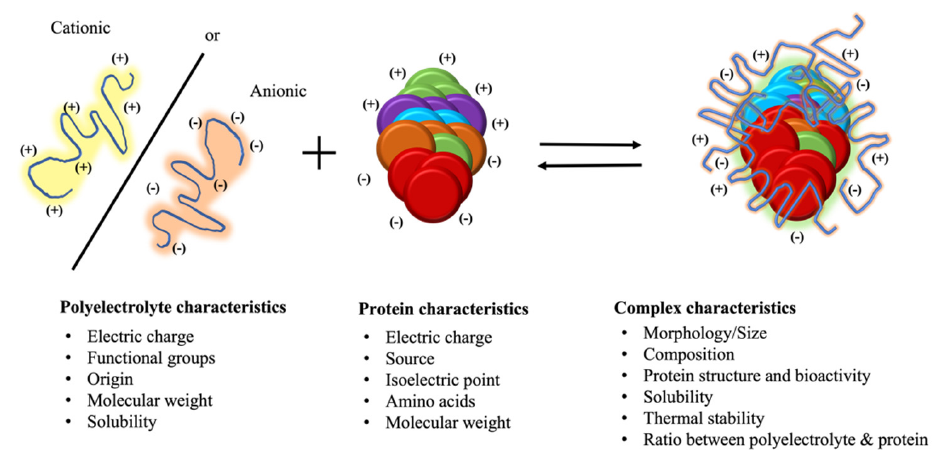
Figure 2. Schematic representation of the key characteristics of polyelectrolytes and proteins to develop the complex formation.